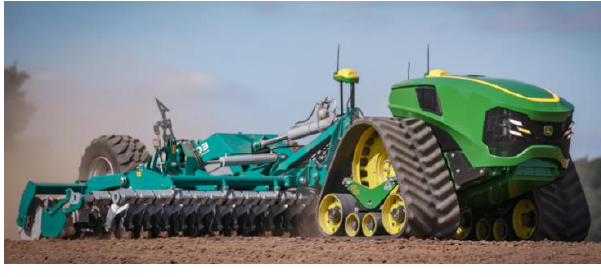
Fig. 30. John Deere Joker [40]